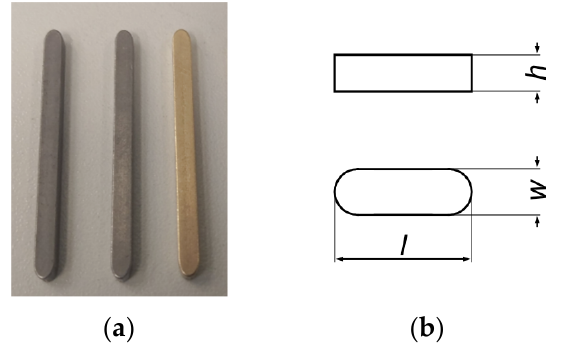
Figure 1. ( a ) Original, cleaned and gold-plated condition of the contact pins; ( b ) technical drawing of feather keys according to DIN 6885.